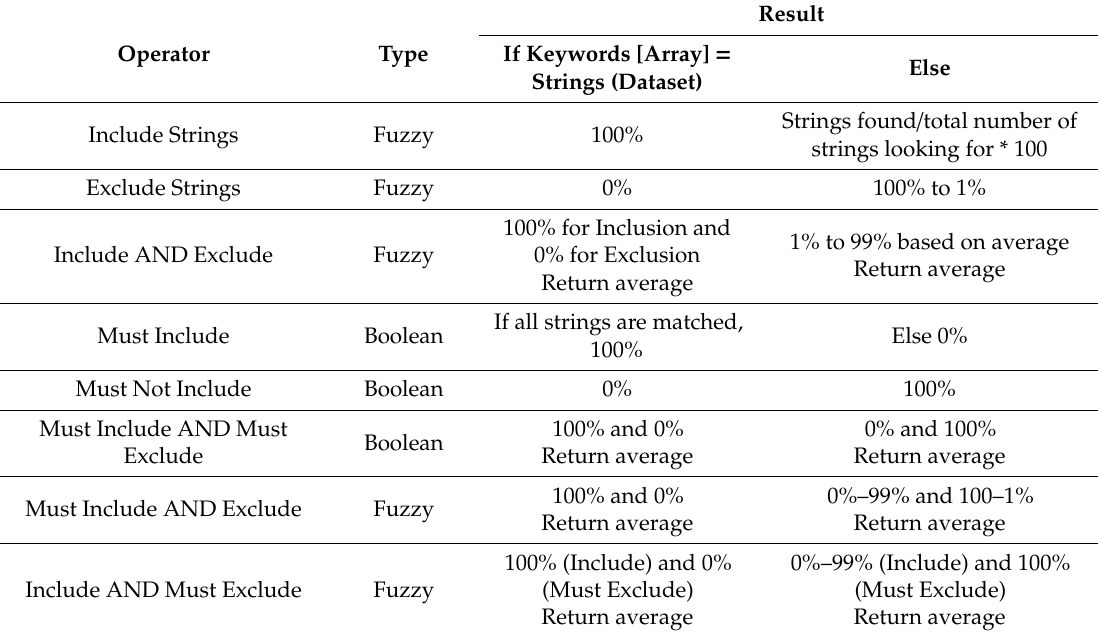
Table 3. Operators used for finding Strings / Text for the selection of